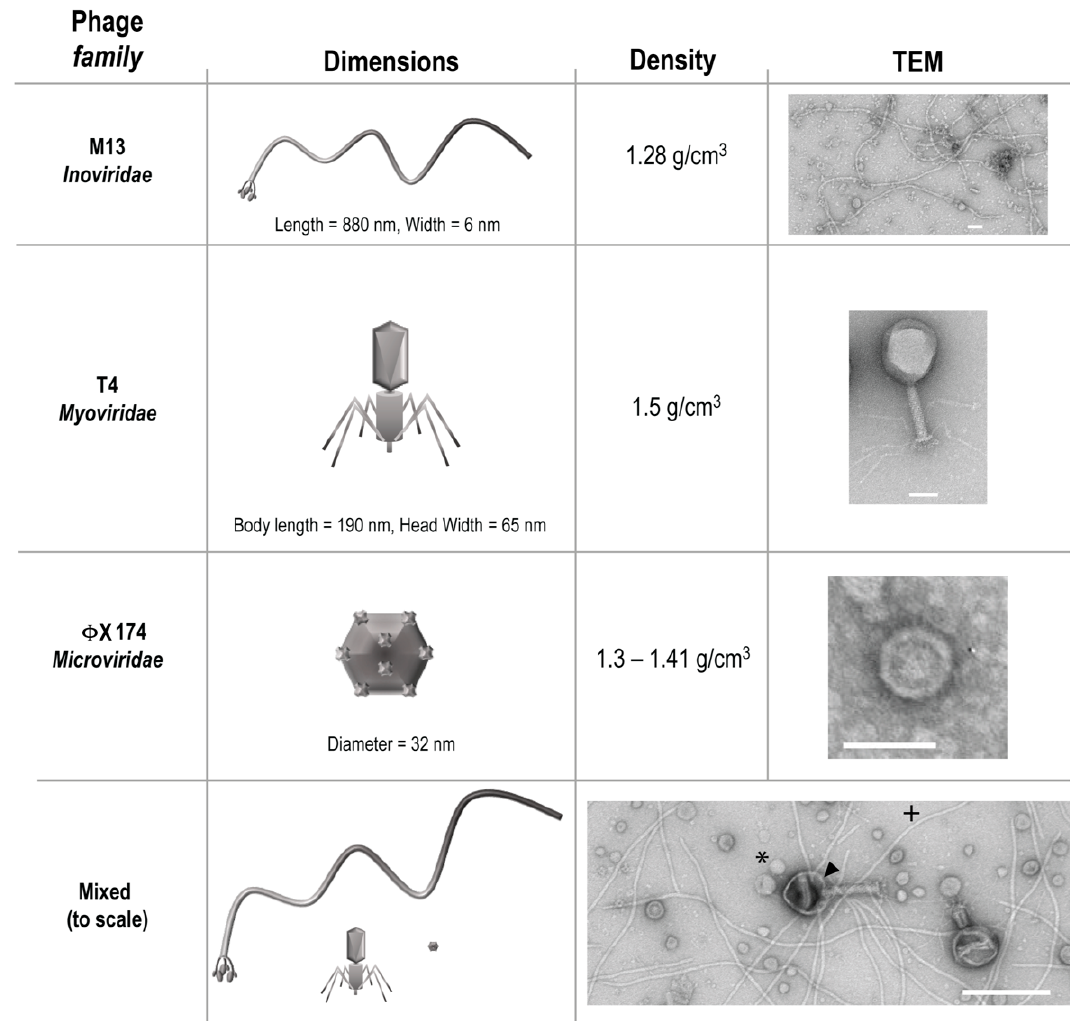
Figure 1. Characteristics of bacteriophage used. Arrowhead = T4, * = Φ X 174, + = M13.